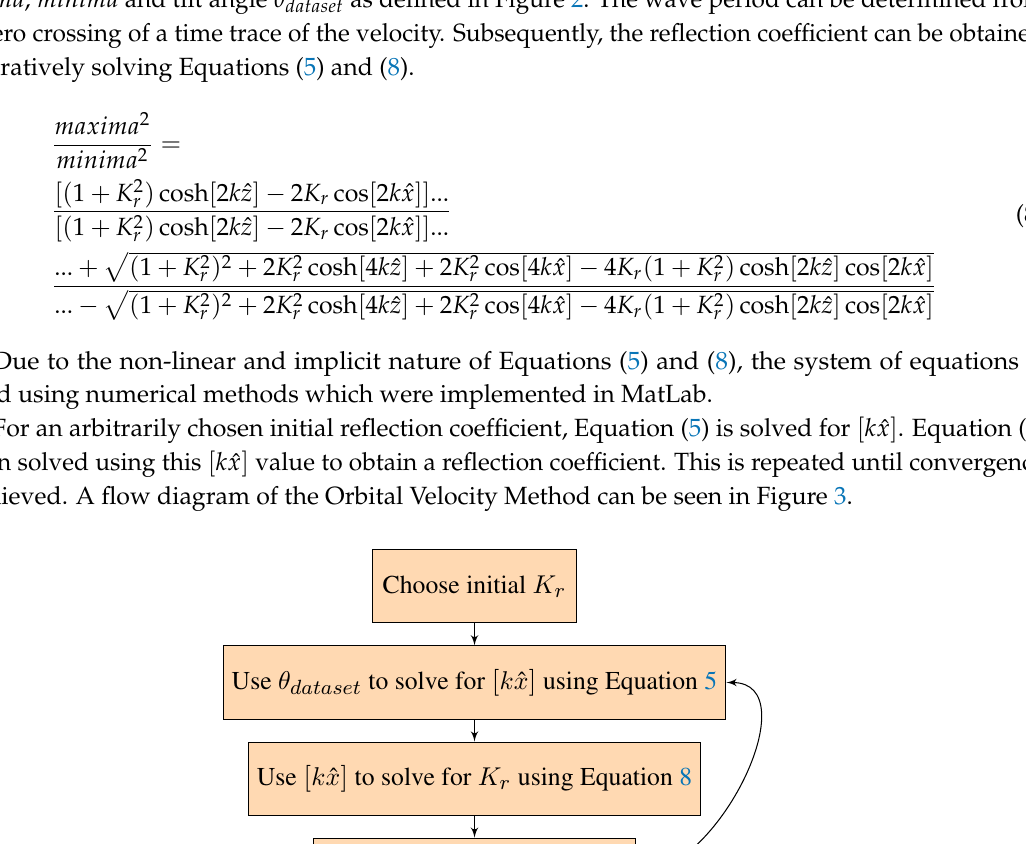
tilt of the ellipse of the dataset and [ k ˆ x ] = ( kx + (cid:101)